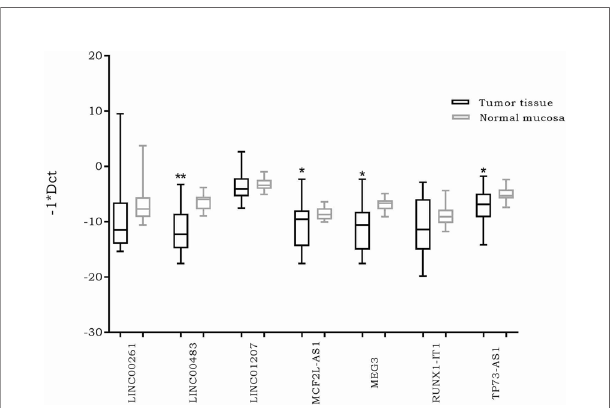
FIGURE 2 | Box plots showing differential expression of the selected long non-coding RNAs (lncRNAs) in 20 formalin- fi xed, paraf fi n-embedded (FFPE) colorectal cancer ( CRC) biopsies compared to normal adjacent tissues. Different primer pairs for DLEU1 did not produce any ampli fi cation. For this reason, DLEU1 data are not shown. *: p-value < 0.05; **: p-value <